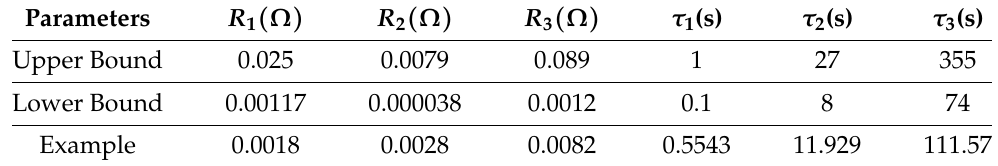
Table 2. Model Parameters bound of a third-order ECM. Example given for 80% SoC and 100% SOH.